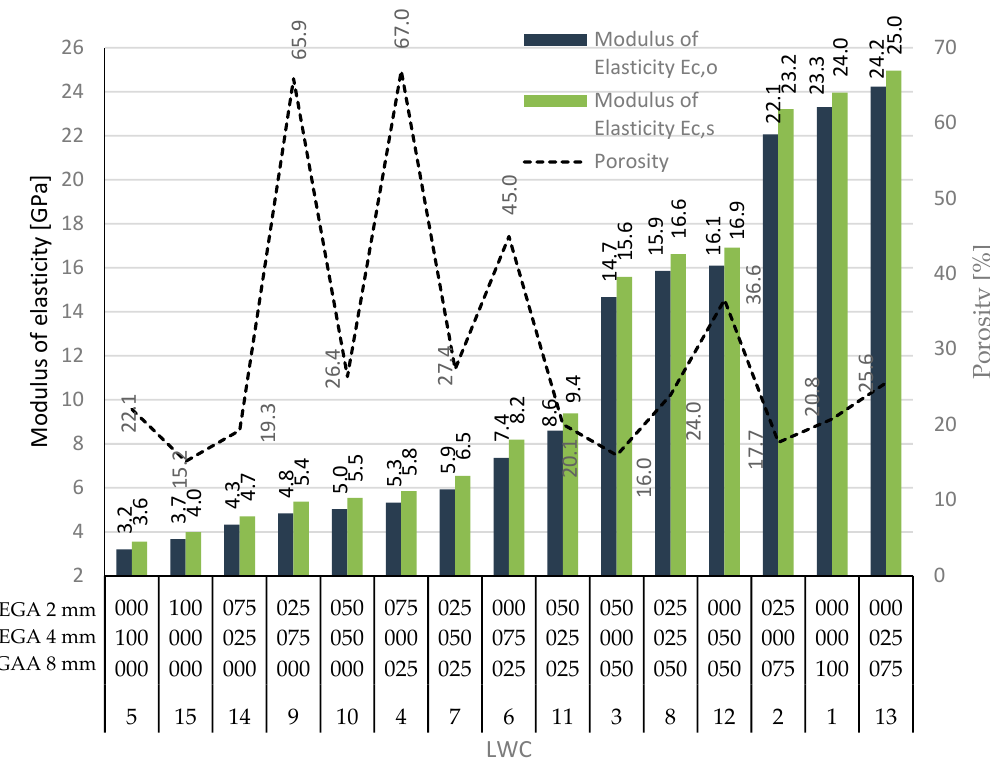
Figure 7. The modulus of elasticity vs. porosity for LWCs 1–15.